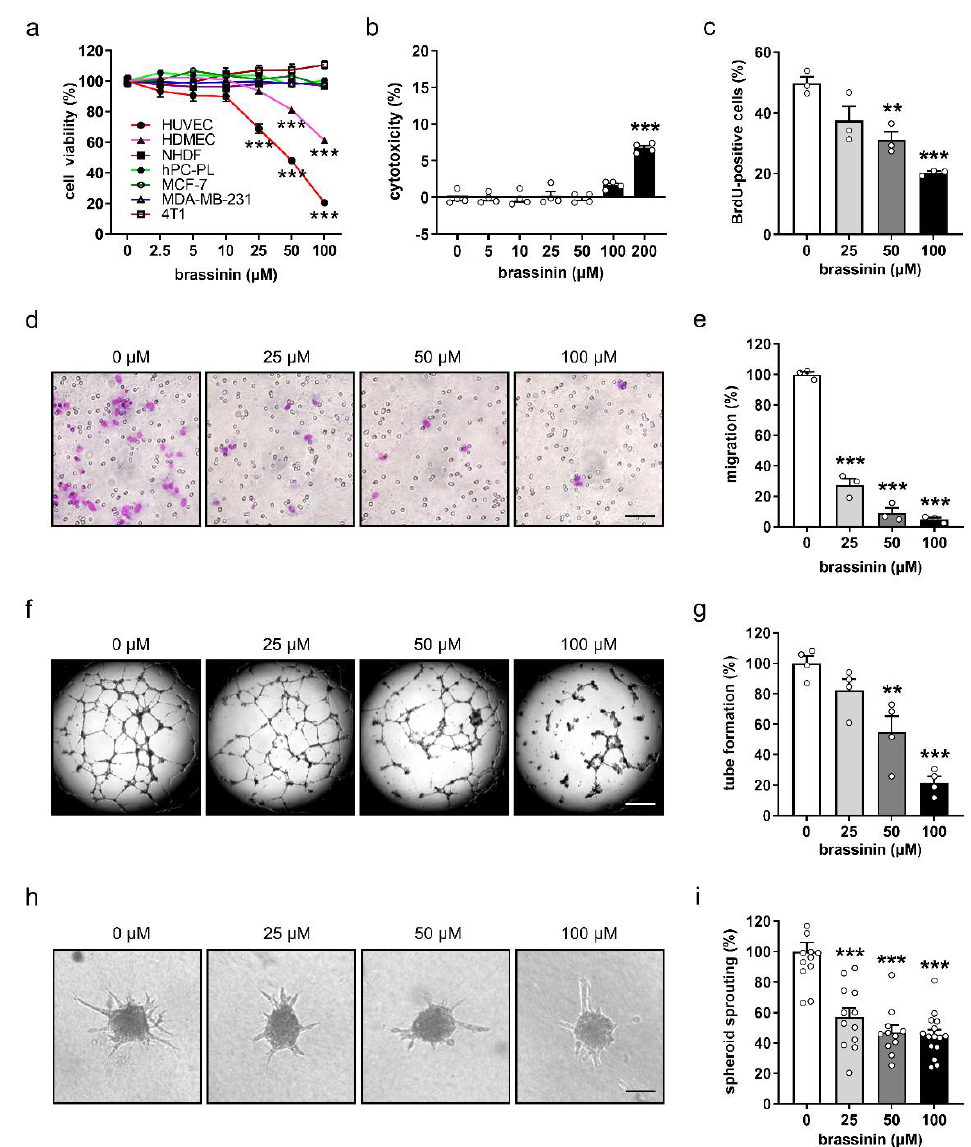
Figure 1. Brassinin preferentially targets ECs and suppresses their angiogenic activity. ( a ) Cell viability (% of 0 µ M) of HUVECs, HDMECs, hPC-PLs, and NHDFs, as well as MCF-7, MDA-MB-231, and 4T1 cells after 48 h exposure to a serial dilution of brassinin ( n = 4). ( b ) Cytotoxicity (% of the total cell death) of brassinin on HUVECs after 24 h exposure to a serial dilution of the compound ( n = 4). ( c ) BrdU-positive HUVECs (% of the total cell number) that were treated for 24 h with 0, 25, 50, and 100 µM brassinin ( n = 3). ( d ) Images of migrated HUVECs that were treated for 24 h with 0, 25, 50, and 100 µM brassinin. Scale bar: 70 µm. ( e ) Migration (% of 0 µM) of treated HUVECs shown in ( d ) was quantified ( n = 4). ( f ) Images of tubes formed by HUVECs. The cells were treated for 18 h with 0, 25, 50, and 100 µM brassinin. Scale bar: 700 µm. ( g ) Tube formation (% of 0 µM) of treated HUVECs shown in ( f ) was determined ( n = 4). ( h ) Images of HUVEC spheroids that were treated for 24 h with 0, 25, 50, and 100 µM brassinin. Scale bar: 95 µm. ( i ) Sprouting (% of 0 µM) of treated HUVEC spheroids shown in ( h ) was quantified ( n = 11 – 15). Means ± SEM. ** p < 0.01, *** p < 0.001 vs. 0 µM.